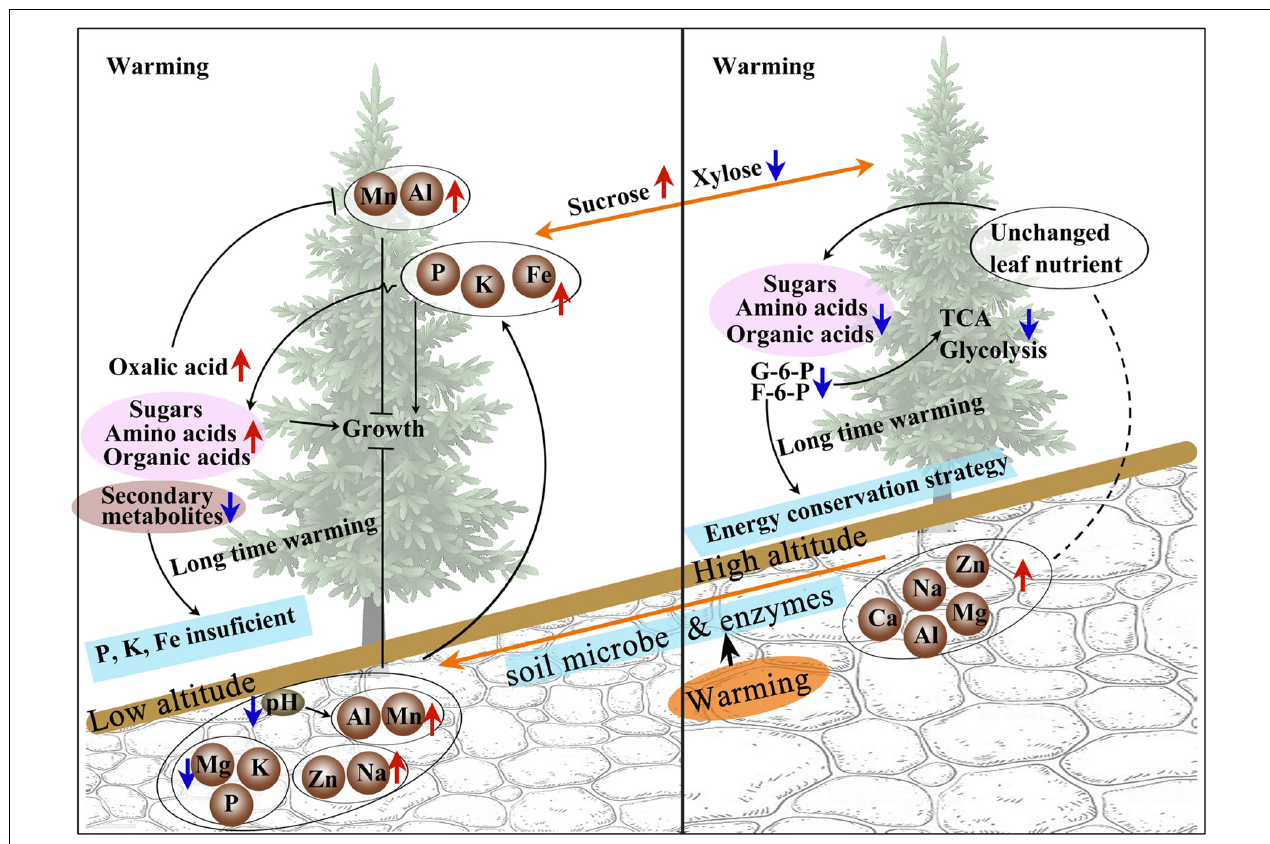
FIGURE 8 | Diagram of A. faxoniana responding to warming at low and high altitudes. F6P, fructose-6-phosphate; G6P,